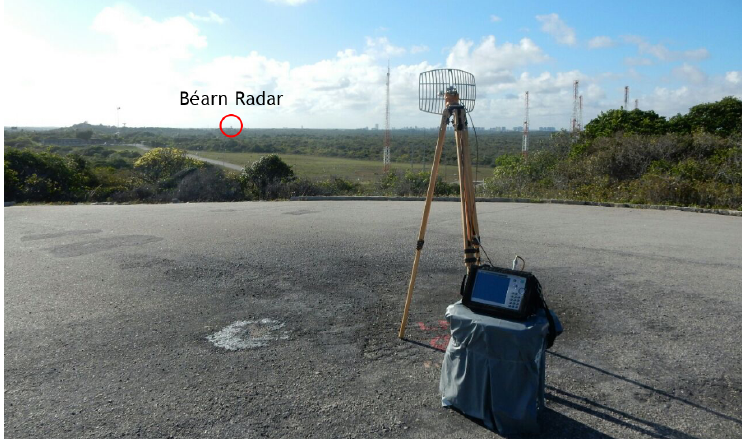
Figure 6. P04 measurement point: mobile launch platform